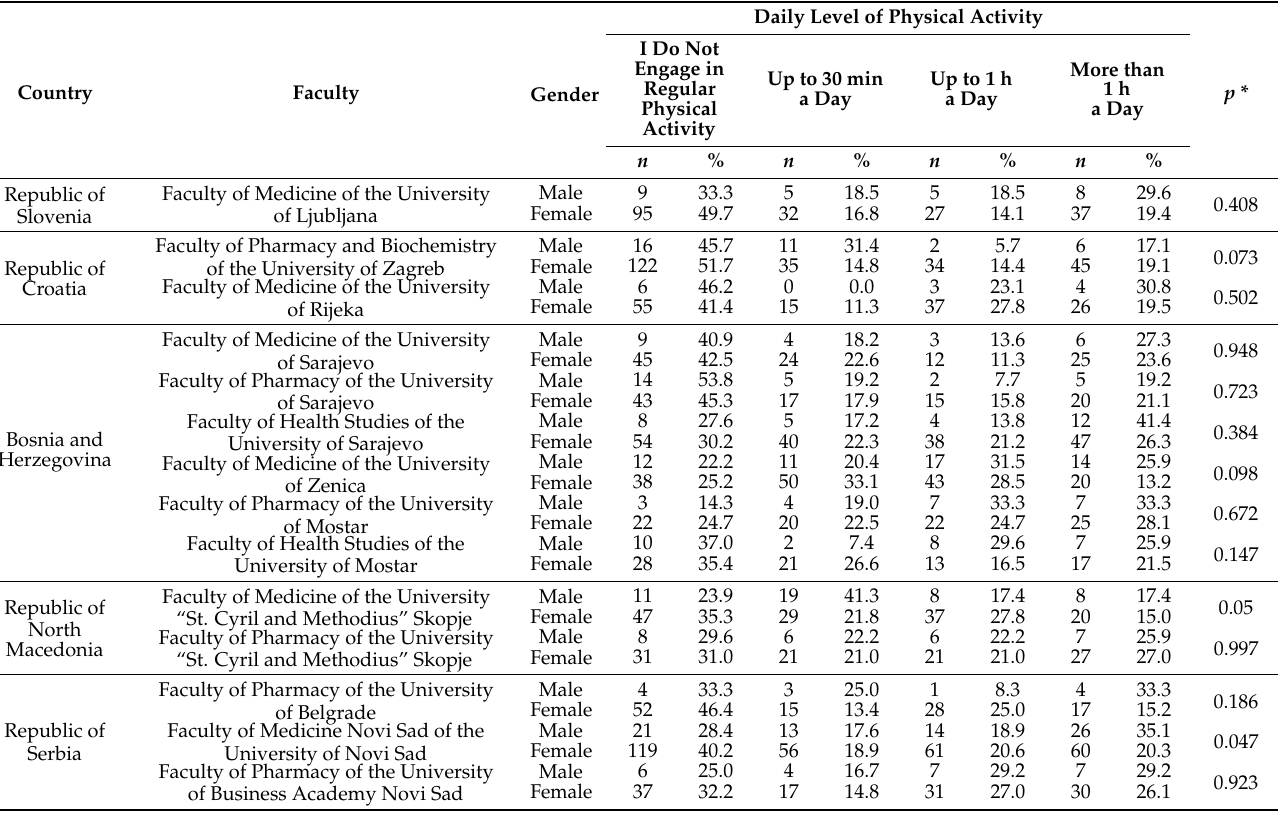
Daily level of physical activity of medical students by gender in relation to the attended